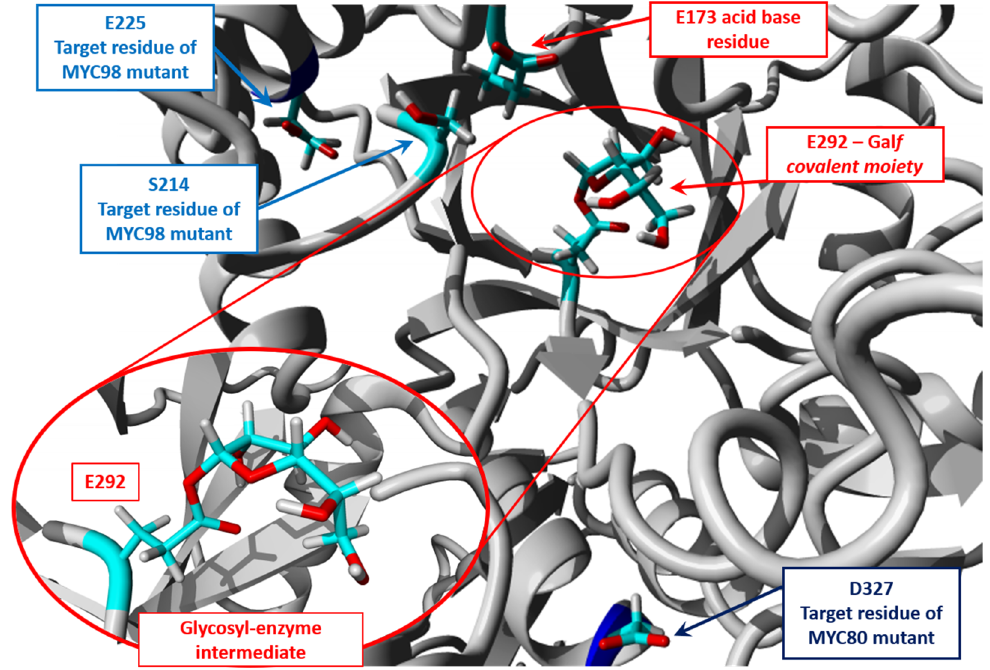
Figure 6. Molecular view of the wild ‐ type Gal f covalent complex with highlight on MYC98 and MYC80 mutations and focus on the glycosidic moiety.